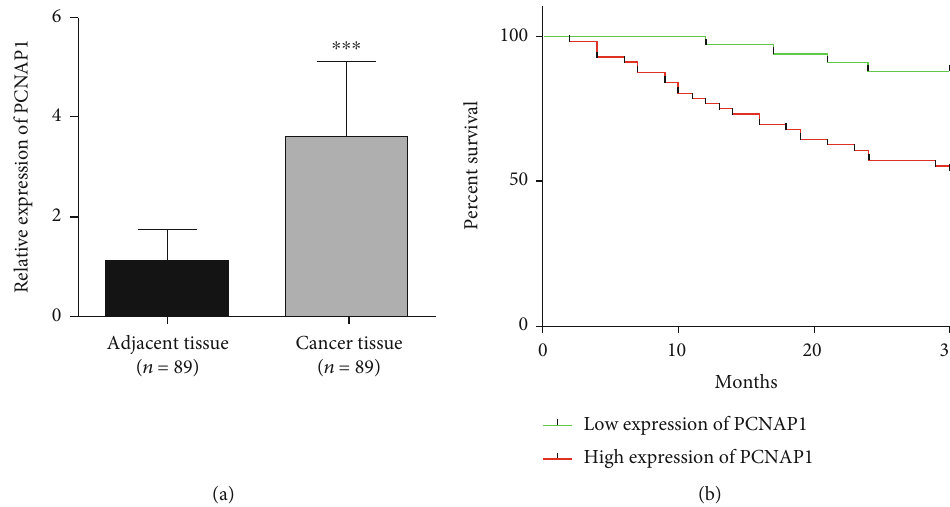
Figure 1: (a) The relative levels of PCNAP1 were examined by RT-qPCR in HCC cancer tissue and adjacent tissue. (b) The relationship between PCNAP1 expression and survival by Kaplan – Meier analysis. Table 1: Relationships among plasma levels of PCNAP1 and patient clinicopathologic